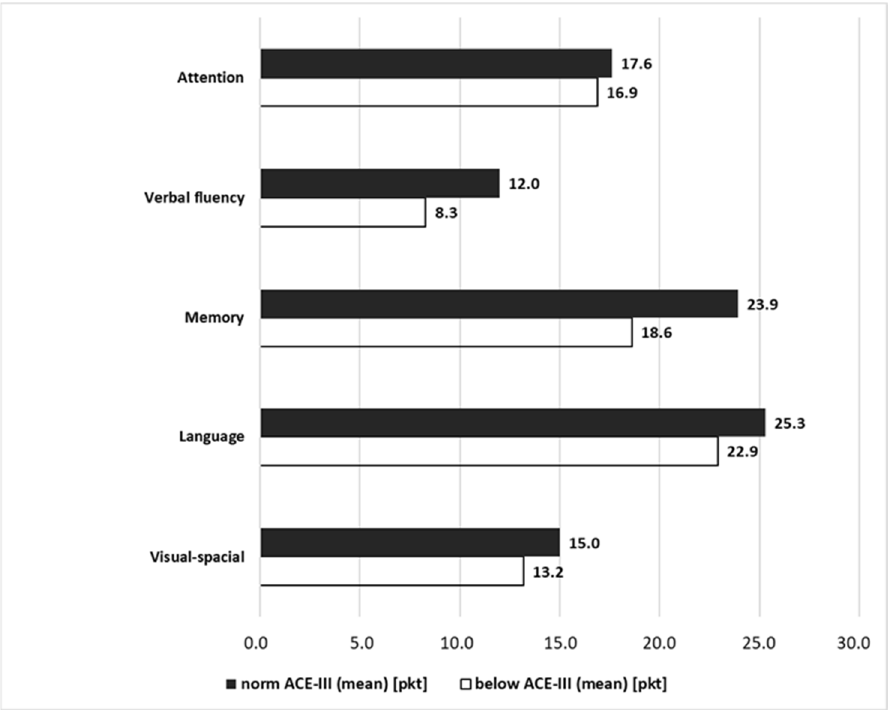
Figure 11. Mean scores as obtained for the five sub-domains by people who scored within the norm and below the norm in ACE-III.